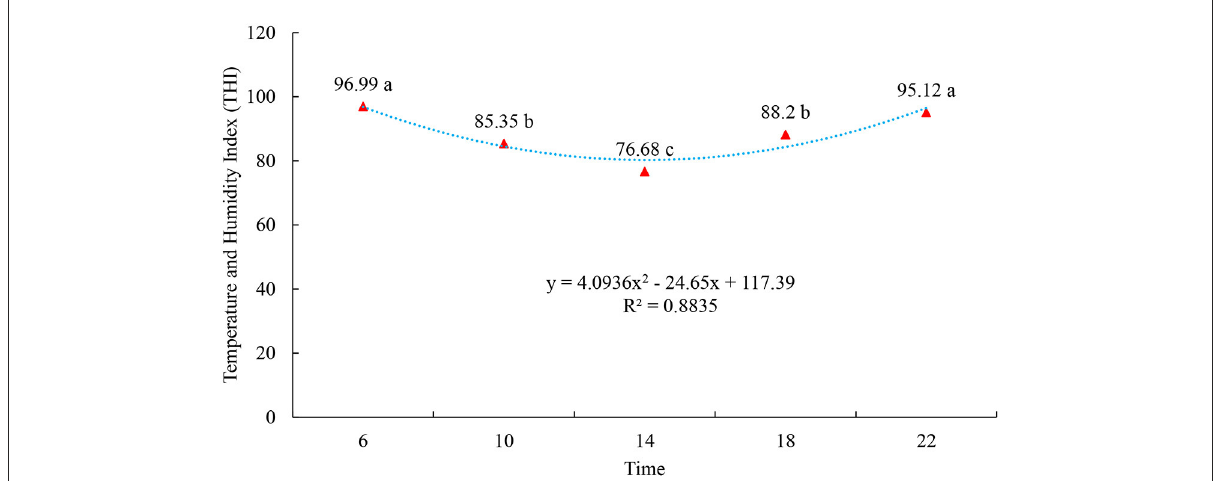
FIGURE1 Temperature and Humidity Index (THI) of the climatic variables observed at 6:00, 9:00, 12:00, 15:00, 18:00, and 22:00h during the experimental period. Different letters indicate statistical differences ( p < 0.05).